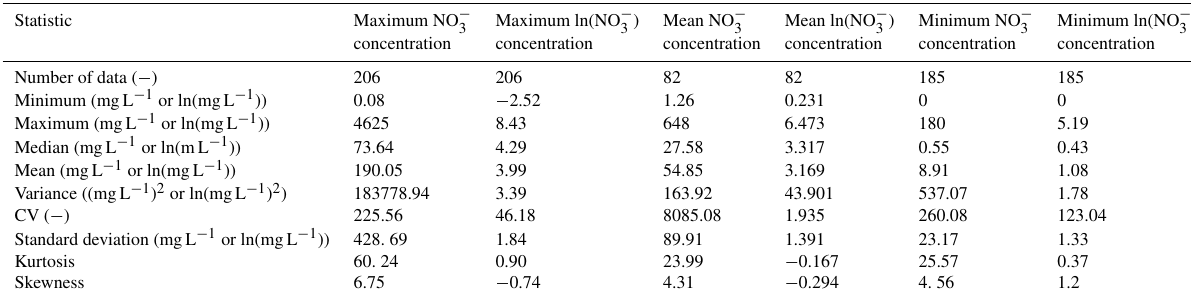
concentration concentration